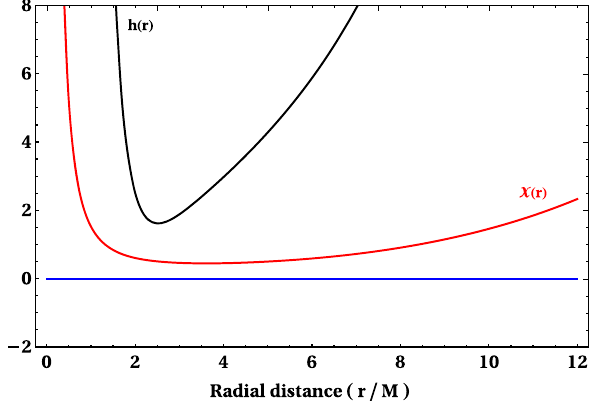
Fig. 2 There occurs neither singularity nor